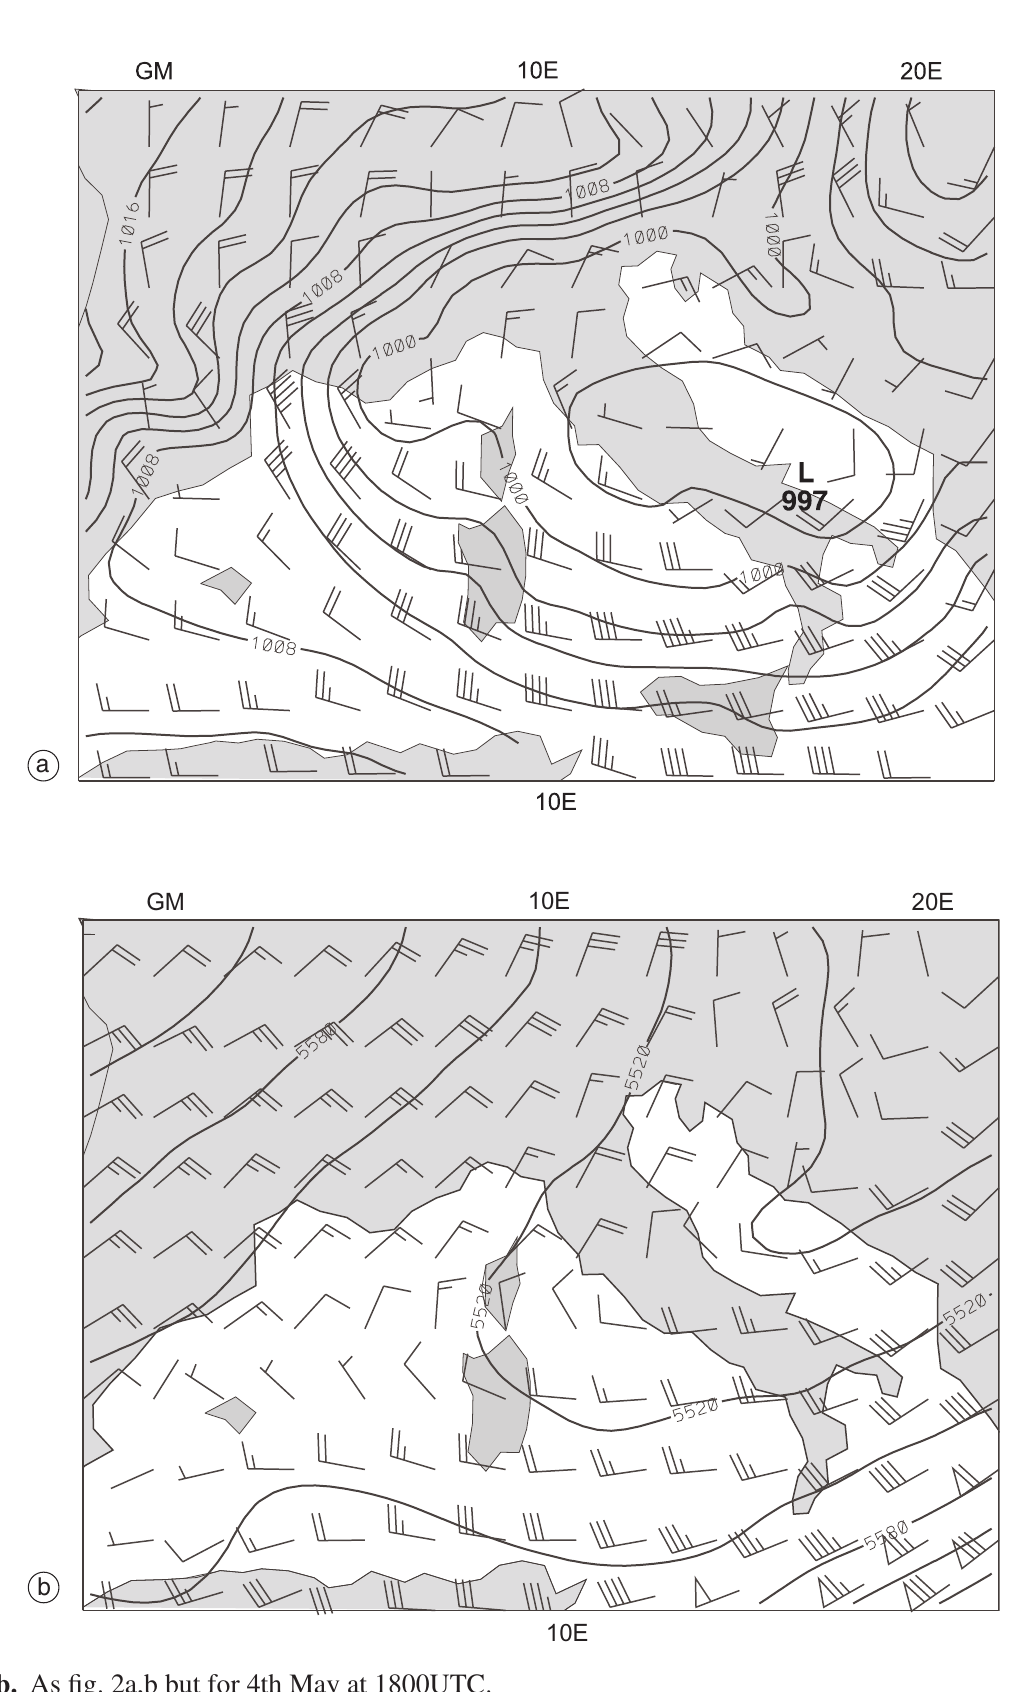
Fig. 3a,b. As fi g. 2a,b but for 4th May at